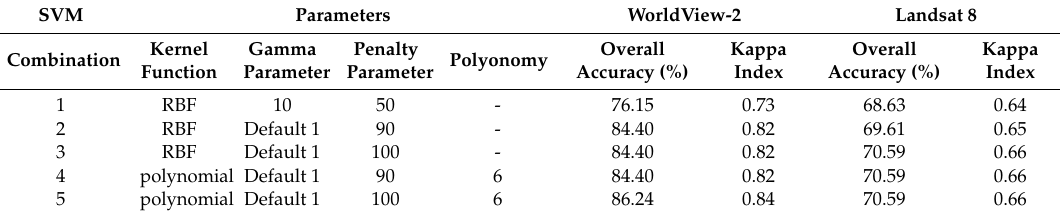
Table 6. Overall accuracy and Kappa index classification of